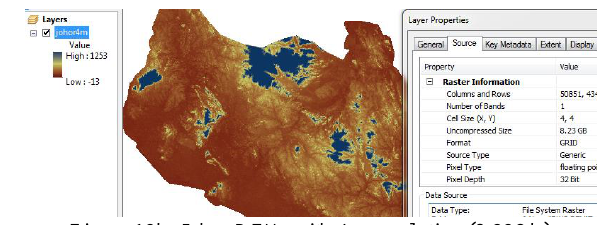
Figure 13b. Johor DEM with 4m resolution (8.23Gb)